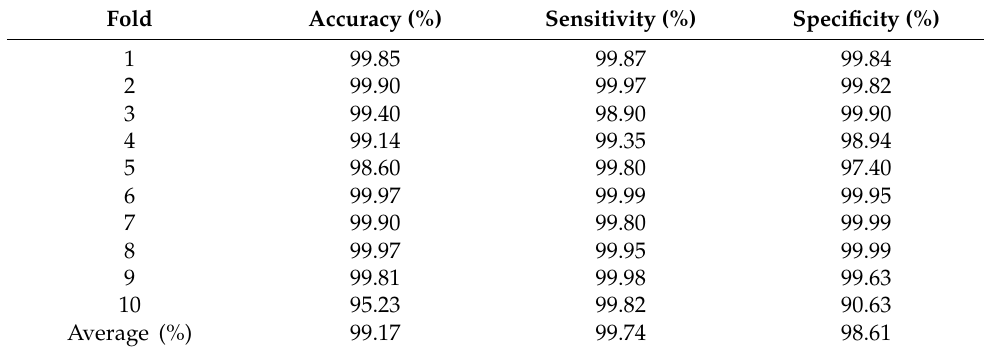
Table 4. Ten-fold evaluation metrics of the hybrid CNN-SVM model (Balanced